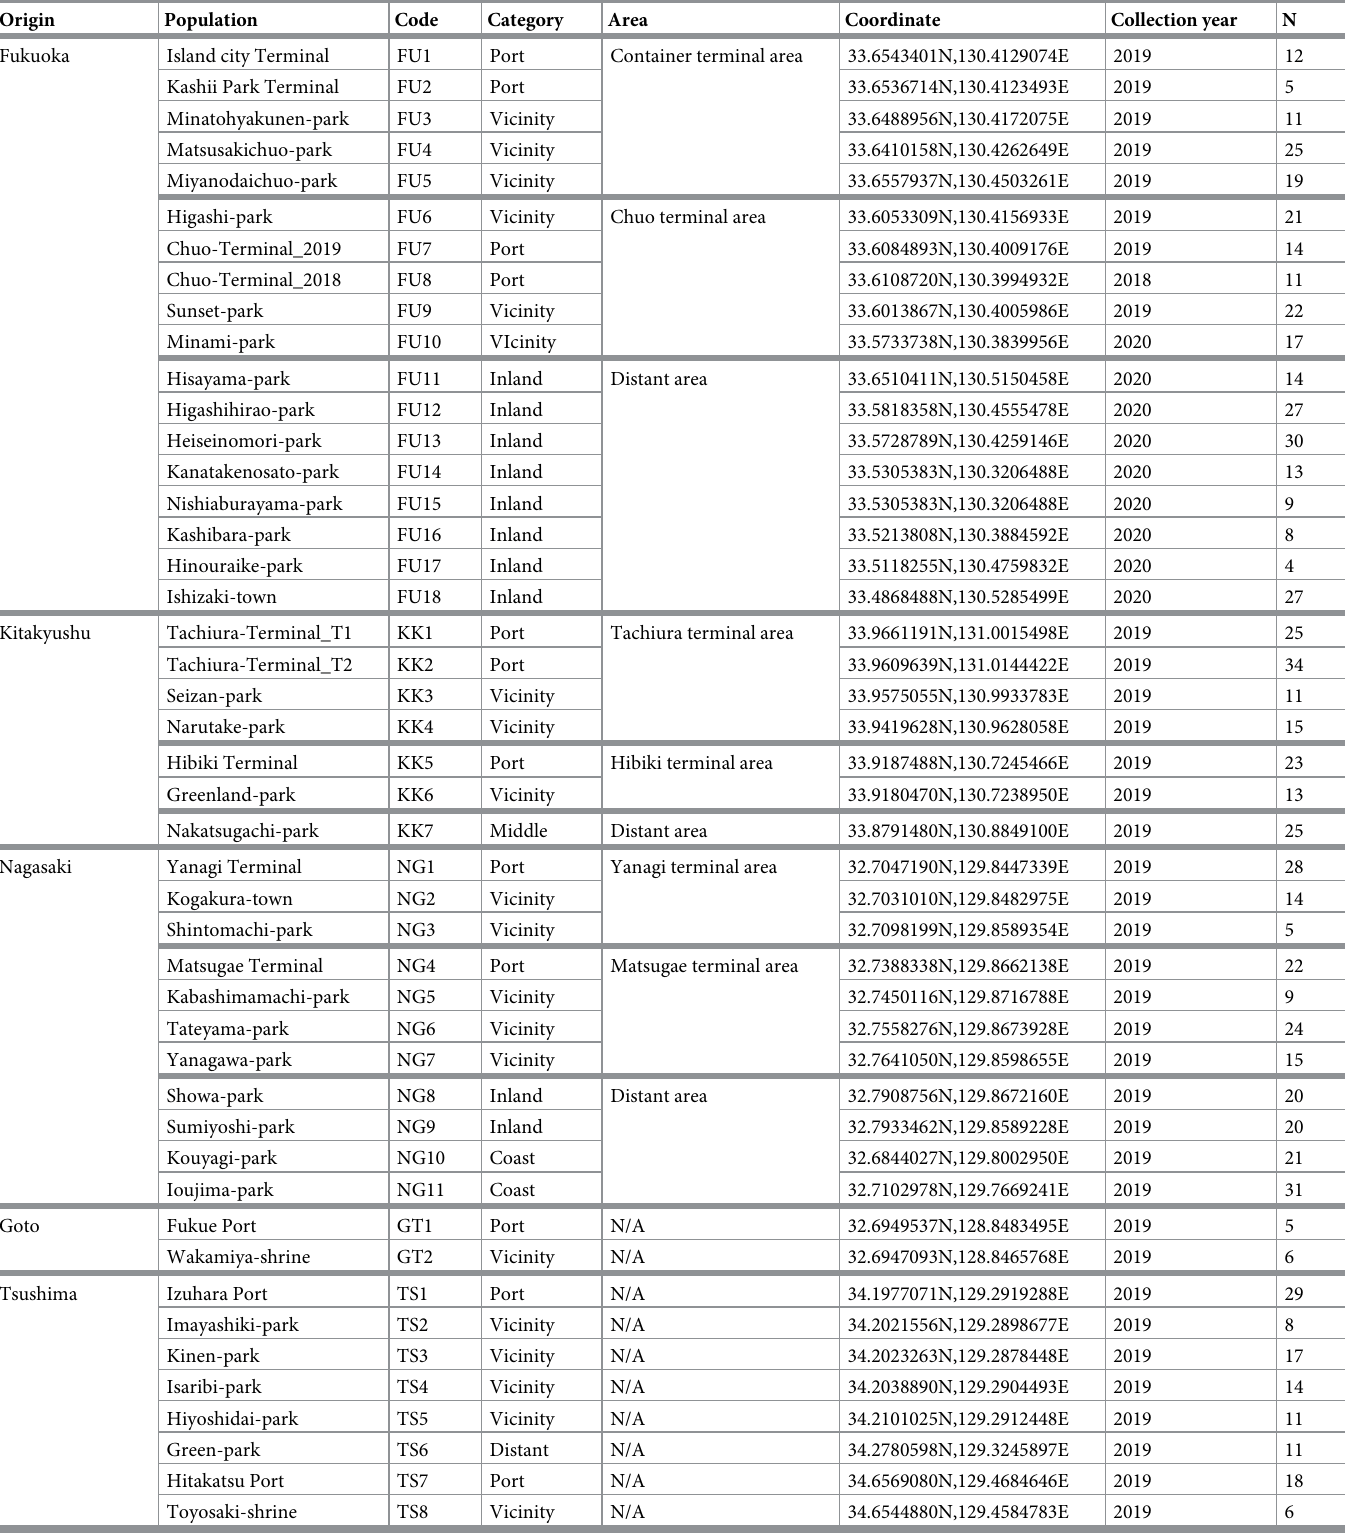
Table 1. Sampling information of each Ae . albopictus population.